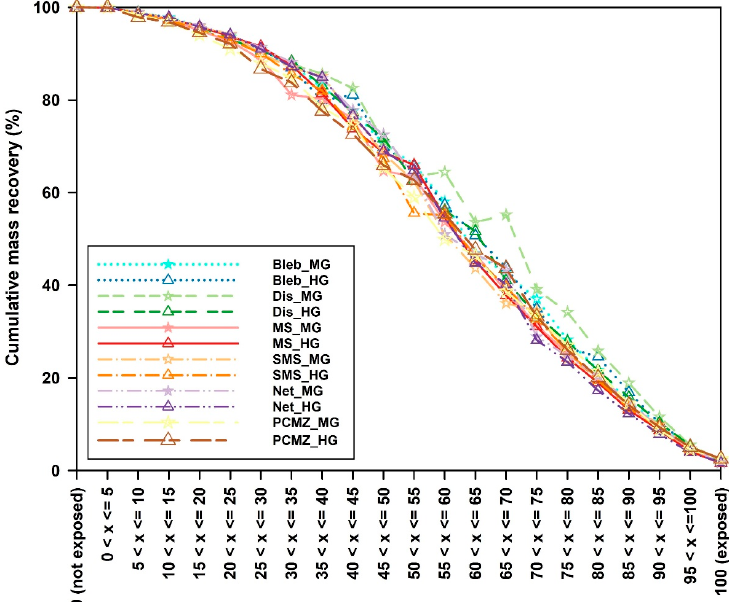
Figure 11. Cumulative liberation yield of pentlandite (weight %) in the − 75 + 38 fractions of feed in the different grind sizes for high- and medium-grade variants of the sulfide ores from the MMZ and the PCMZ.